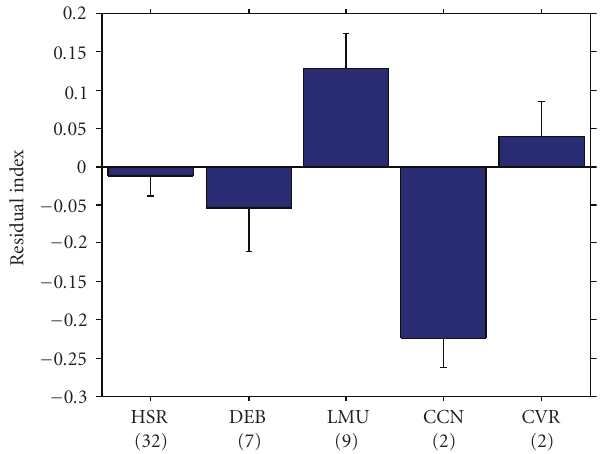
Figure 3: Means ( ± SE) of the residual index for field-collected Peucetia viridans females by sample site. Site abbreviations are defined in the text and sample sizes are indicated in